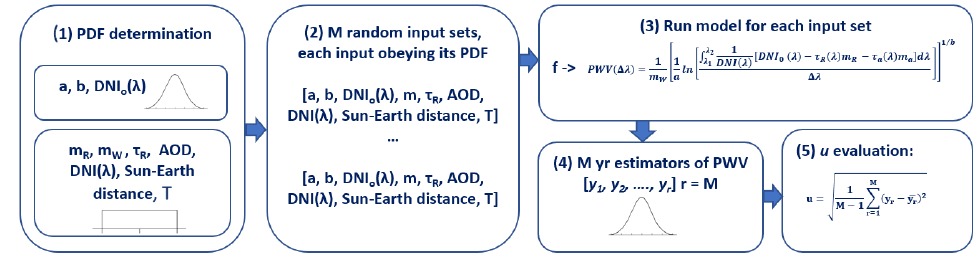
Figure 4. Schema of the Monte-Carlo method procedure applied for the uncertainty evaluation. The temporal evolution of the EKO PWV amounts between April and December 2019 and the relative U PWV is shown in Figure 5. The relative U PWV ranges between about 3% (0.13 mm) and 34% (0.81 mm) with a mean and standard deviation of 9.8 ± 4.1% (0.37 ± 0.11 mm), respectively. From this figure the dependence of the U PWV on the PWV content (Figure 6) becomes evident: higher PWV amounts provide lower relative U PWV values. For PWV ≤ 5 mm (62% of the data), the mean of the U PWV is 11.9 ± 3.9% (0.31 ± 0.07 mm), while for PWV> 5 mm (38% of the data) is 6.5 ± 1.1% (0.47 ± 0.08 mm). Also, U PWV shows a strong dependence with AOD (Figure 6), again the higher AOD values lead to lower relative U PWV . For AOD ≤ 0.10 (95% of the data), the mean of U PWV is 10.1 ± 4.1% and for AOD > 0.10 (5% of the data) the mean decreases until 5.9 ± 1.4%.